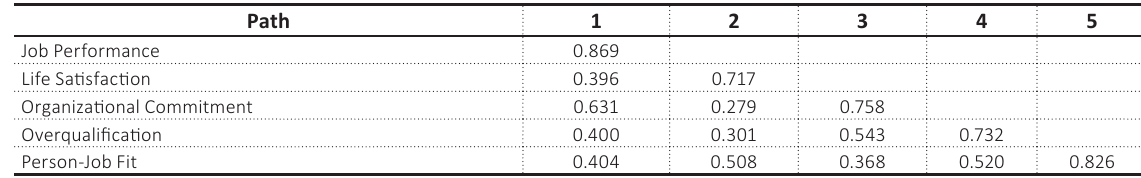
Table 3. Discriminant validity